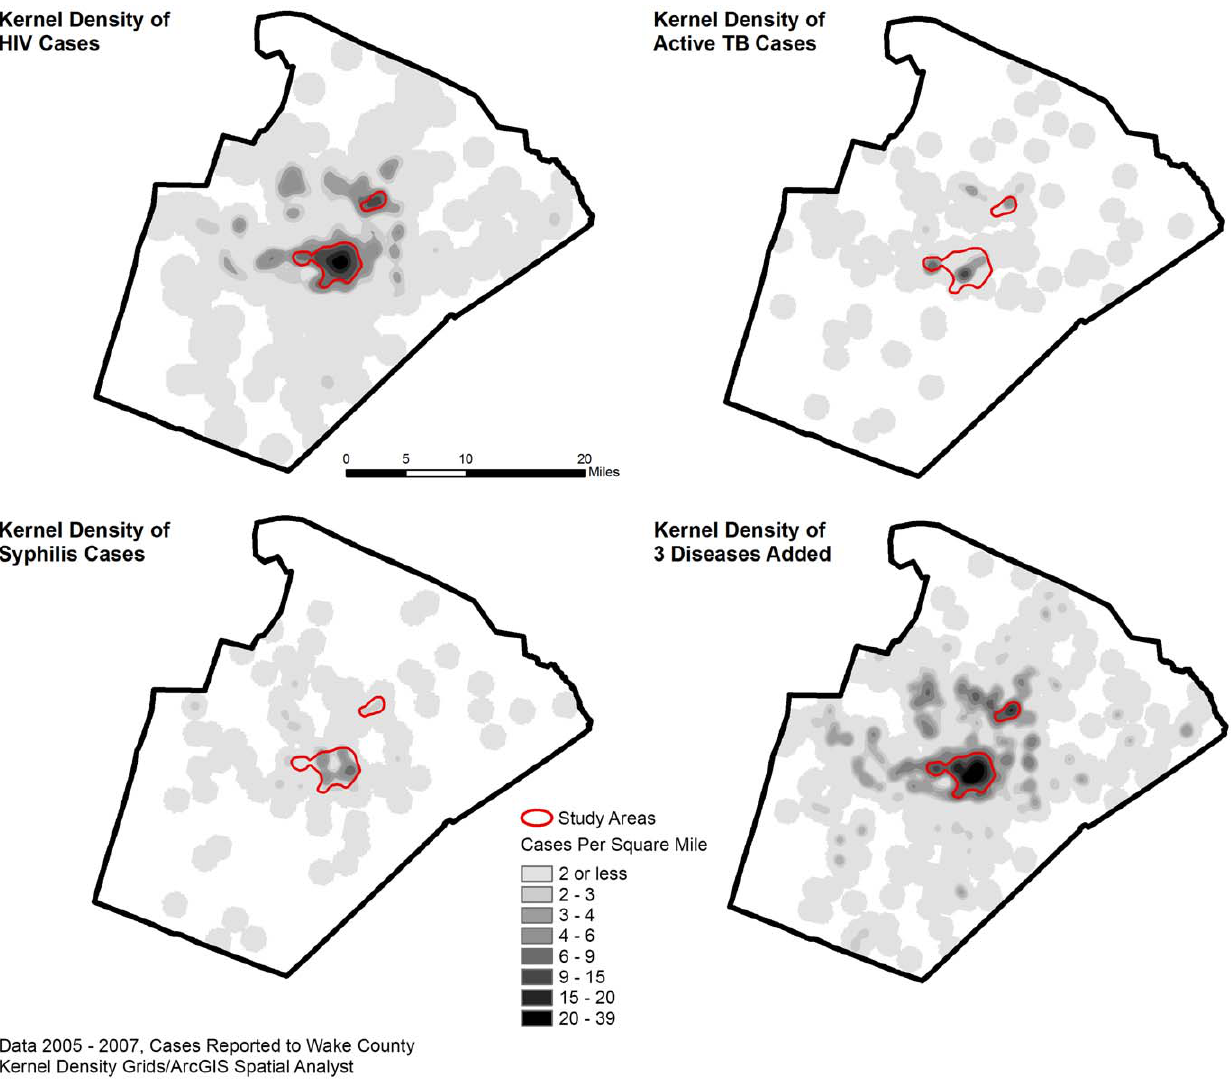
Figure 1. HIV, Syphilis and Active Tuberculosis Cases, 2005–2007. Based on public health surveillance data from January 2005 through December 2007, disease-specific cases were geocoded, including 665 HIV cases, 150 active TB cases, and 155 syphilis cases, with a match rate of 93%. An overlay map with data for all three diseases was used to identify two high-density ‘‘hot spots’’ (outlined).